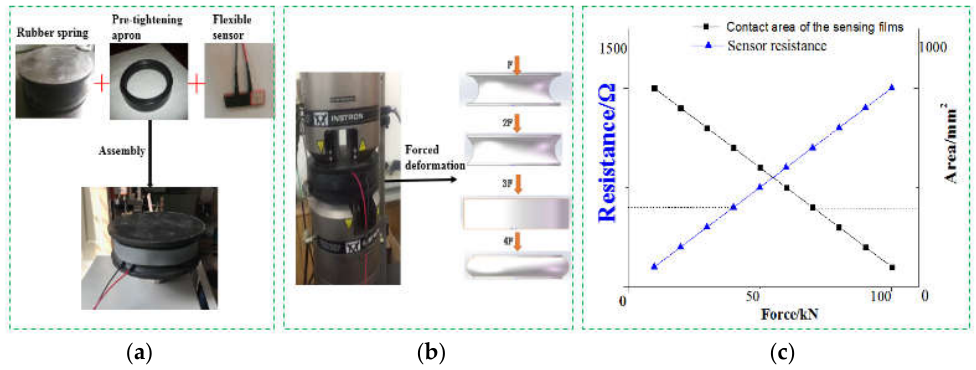
Figure 7. The installation and working diagram of sensor and spring. ( a ) Assembly. ( b ) Spring deformation diagram. ( c ) Piezo-resistive characteristics.